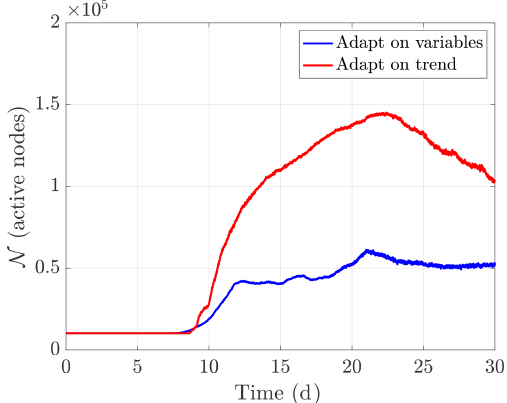
Figure 9. Comparison of the number of active nodes N for the baro- clinic instability when adapting on the trend or adapting on the solu- tion. The relative error threshold was set to ε = 0 . 04 when adapting on the solution and ε = 2 . 6 when adapting on the trend. In both cases, the active scales are j = 5 , 6 , 7 and there is no additional dif- fusion. The tolerances were set to achieve similar compression ra- tios at 9 days. The total number of available grid points is 8 . 6 × 10 5 , and so the minimum grid compression ratio is 3.6 when adapting on the solution and 1.5 when adapting on the trend. The average com- pression ratio is 5.2 when adapting on the solution and 2.1 when adapting on the